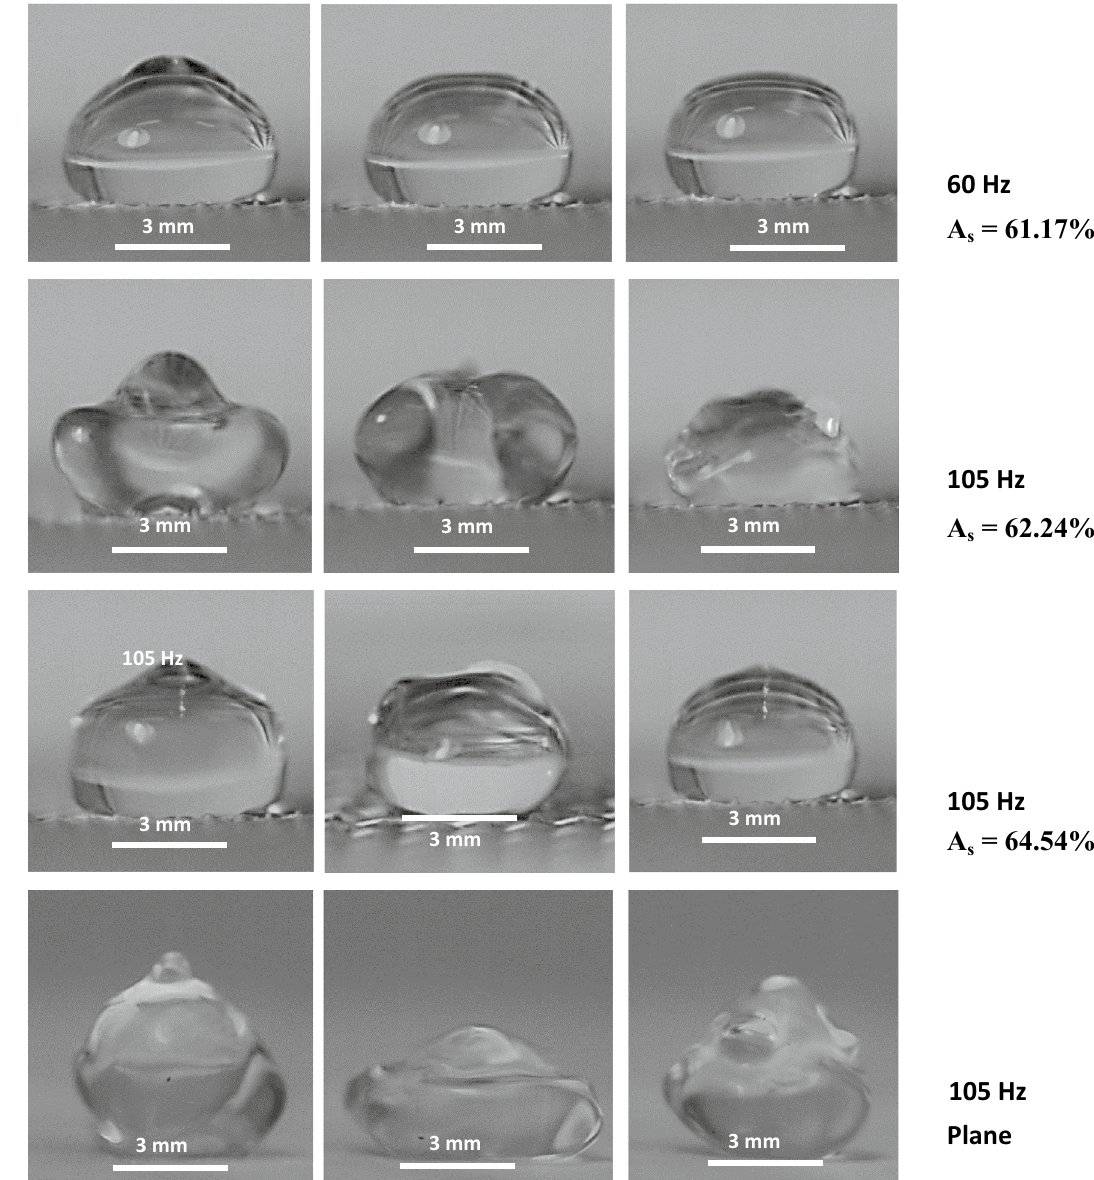
Figure 7. Optical images of droplets obtained from high-speed camera for various mesh screen open aperture ratio ( A s ) and plane hydrophobic